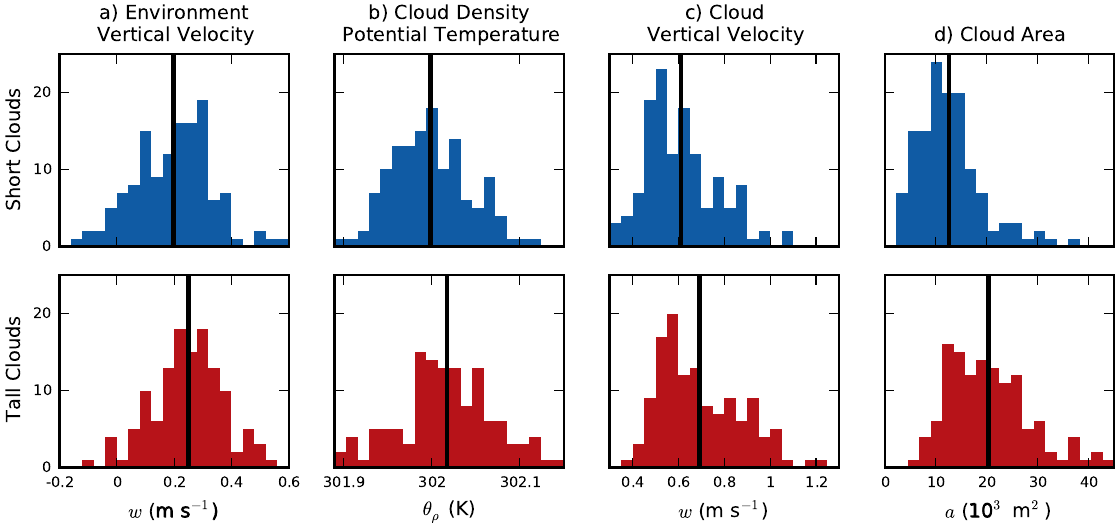
Fig. 15. Probabilities in range 1x ( P(x)1x ) of the mean properties of cloud tops between 550–750m having a certain (a) environmental vertical velocity, (b) cloud density potential temperature, (c) cloud vertical velocity, and (d) horizontal cloud cross-sectional area. Top row, blue histograms show clouds with maximum height less than 1150m; bottom row, red histograms show clouds with maximum height greater than 1150m. Black lines show mean value of each